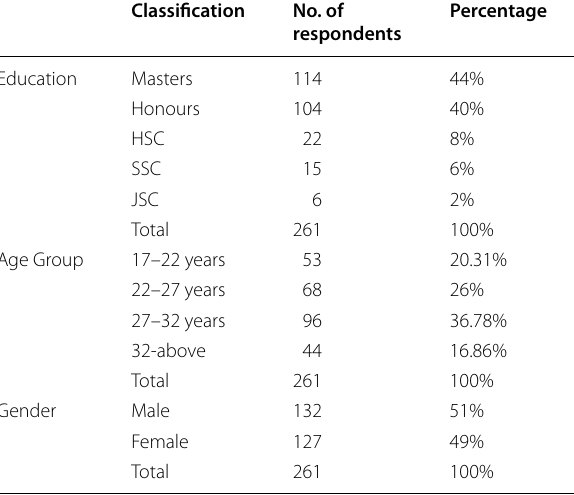
Table 1 Demographic profile of the